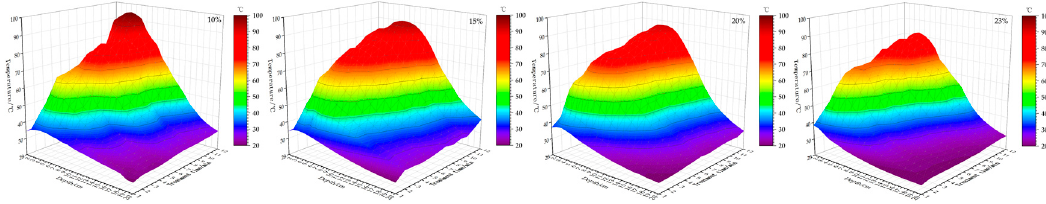
Figure 26. Variation in the internal temperature of loess with irradiation time and soil depth.